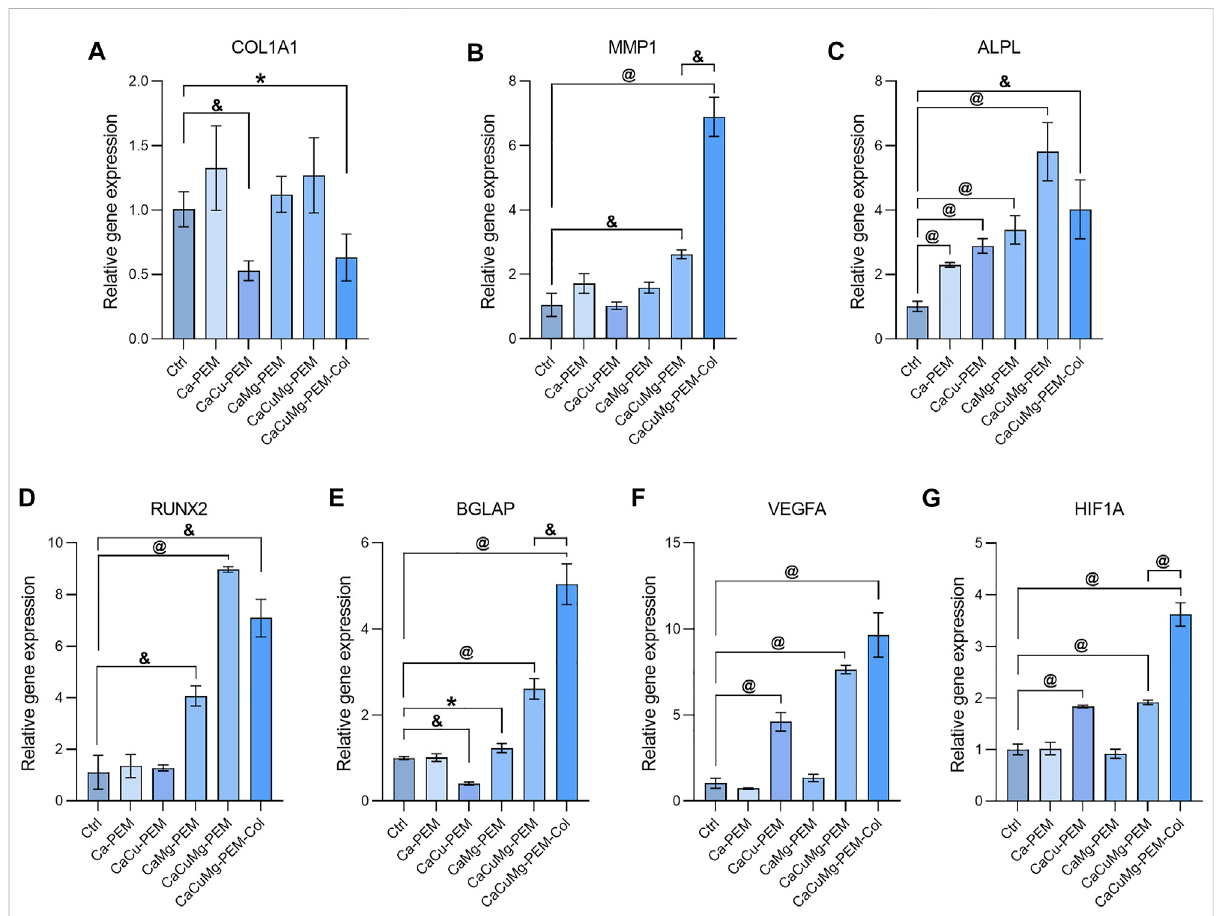
FIGURE 8 Relativegeneexpressionof (A – E) osteogenicmarkersand (F , G) angiogenesismarkersat14 daysanalyzed via qRT-PCR( n =3;Paired t -test,* p < 0.05, & p < 0.01, @ p <